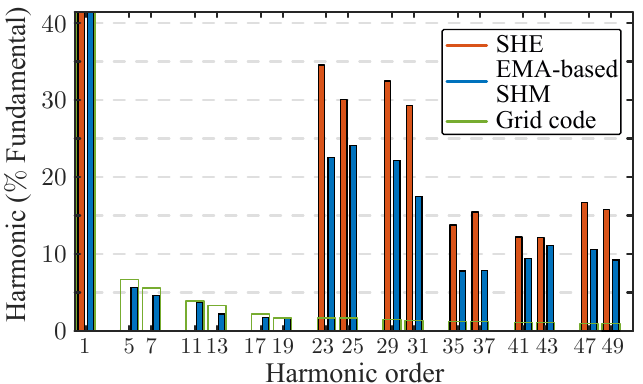
Figure 9. Comparison between the worst case of the EMA-based SHM and SHE for modulation indexes in the range m a = 0.1 to m a =